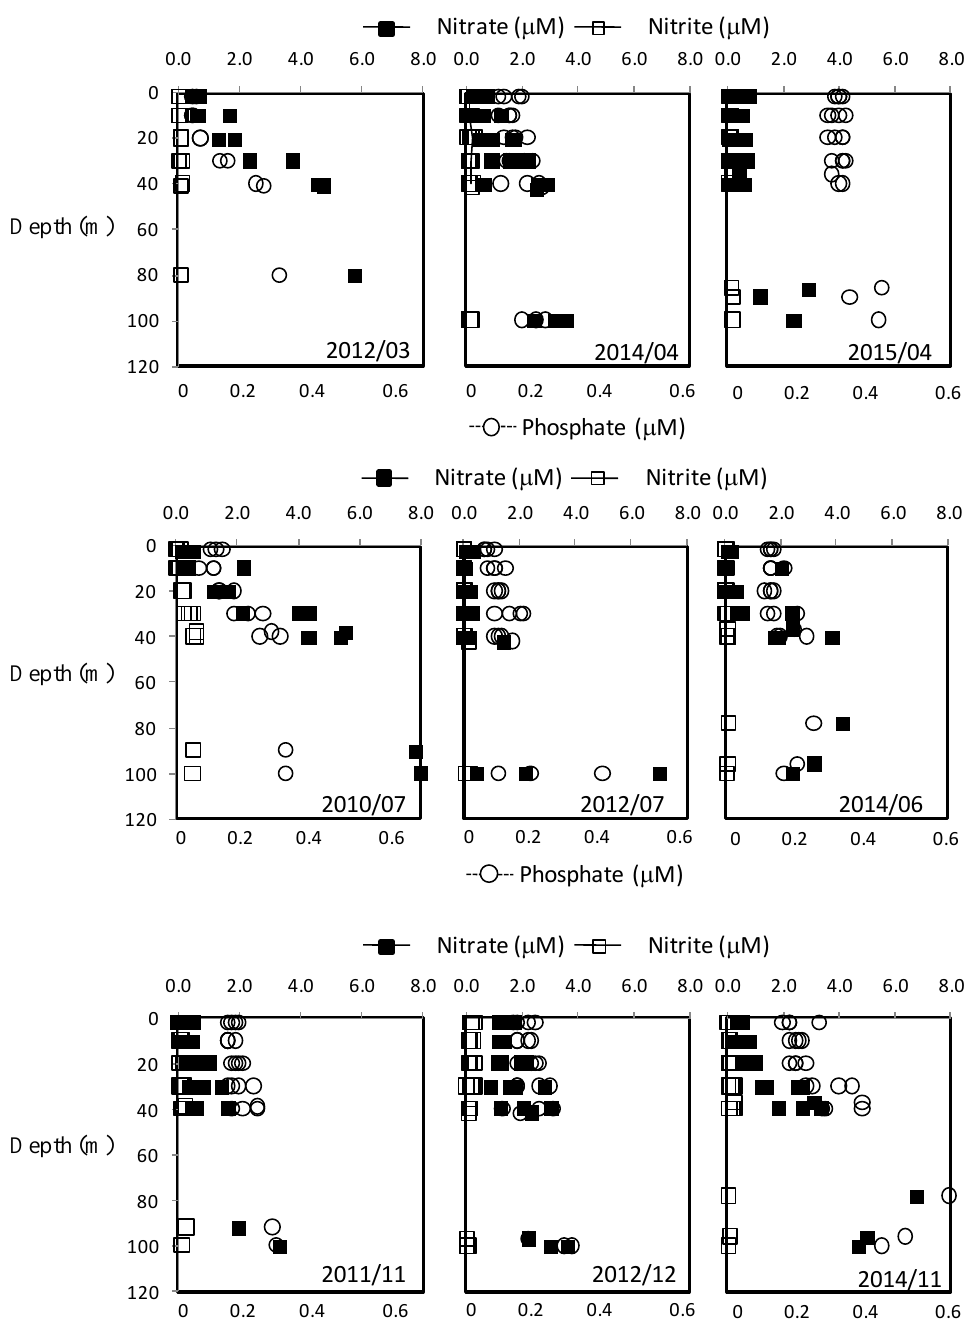
Figure 4. Variation along depth of nitrate, nitrite and phosphate concentrations obtained during surveys in the Bay of Algeciras. For each depth, the concentrations obtained in the four sampling stations are shown. Data were grouped according to three seasonal periods: spring (top), summer (middle), and autumn (bottom).